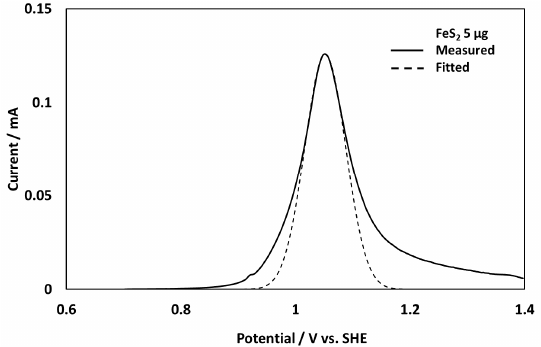
Figure 3. Pyrite voltammogram and the result of peak fitting with a Gaussian function. The pyrite voltammogram is the result of potential polarization with 5 µg of pyrite that is attached to the platinum plate surface.